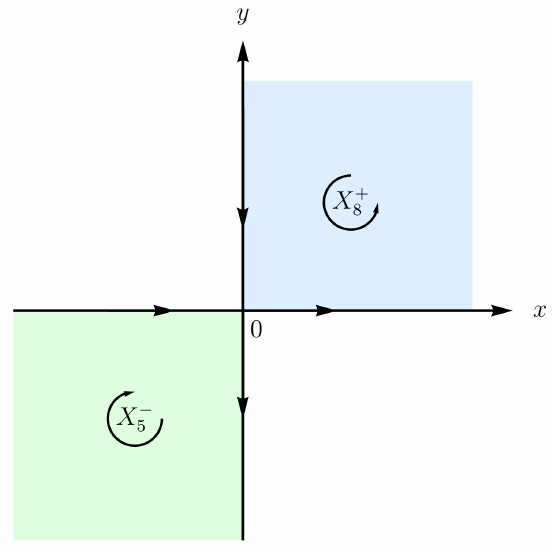
Figure 3 . Example of an oriented sum of positive geometries which is not a positive geometry.